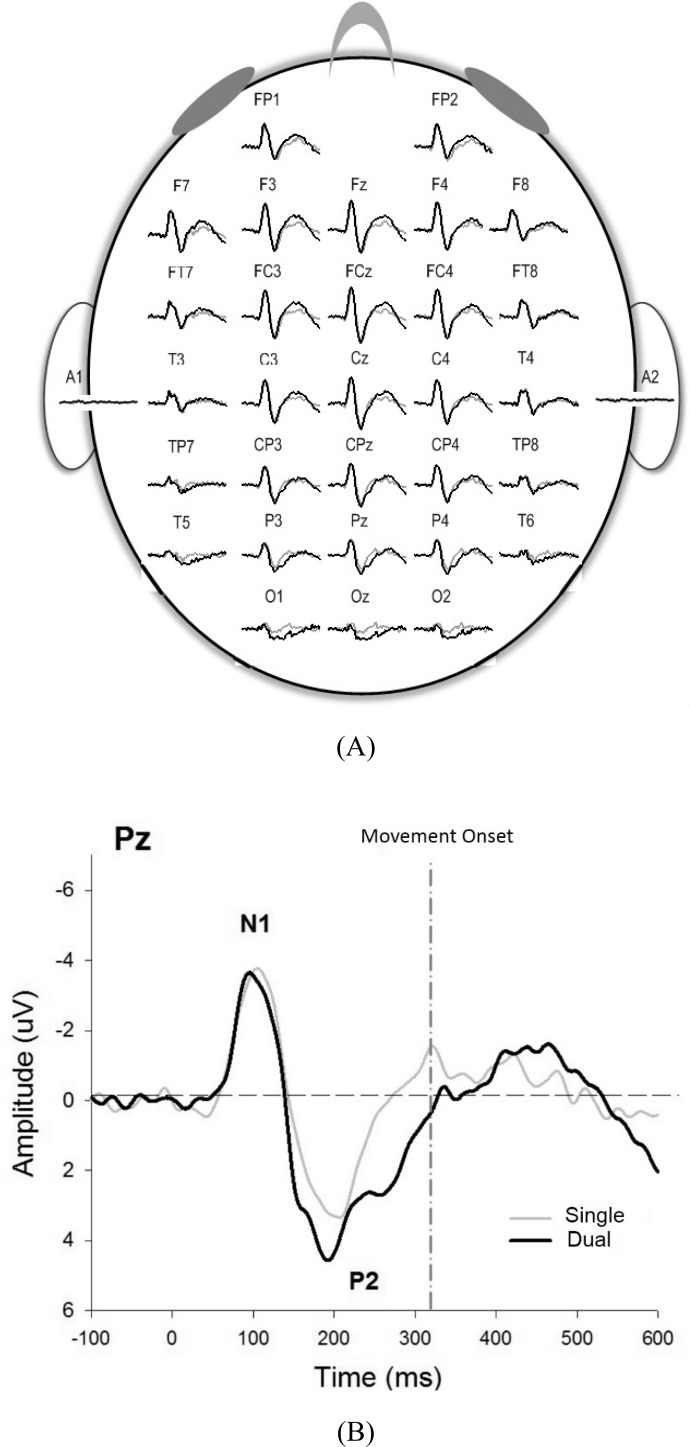
Plots of grand-average ERPs.(A) Grand-average ERPs recorded from all 12 subjects in the single-posture and dual-task conditions. (B) A grand average ERP waveform of the Pz electrode with two major ERP components (N1 and P2) before force-matching in the dual-task condition. The characteristic changes in N1 and P2 between components reflects the cognitive cost of the added force-matching superimposed on a stabilomater stance (grey line: single-posture condition; black line: dual-task condition).